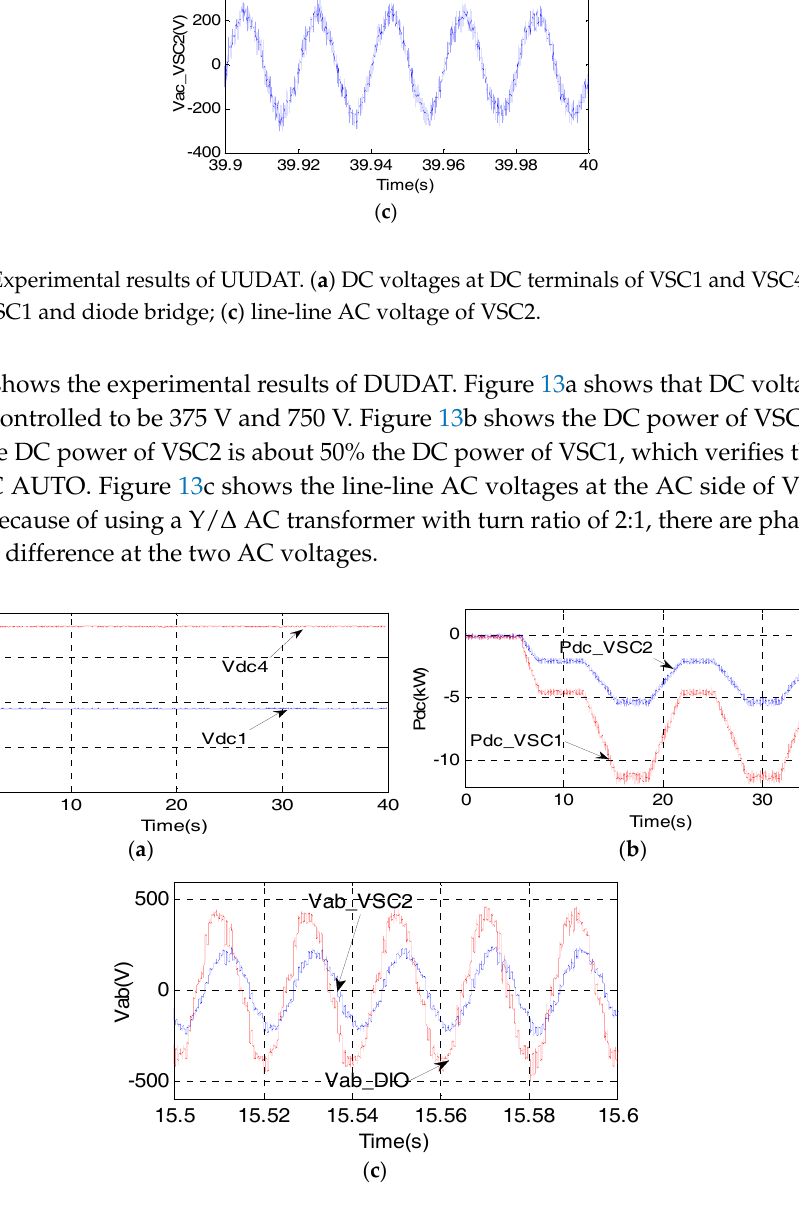
Figure 13. Experimental results of DUDAT. ( a ) DC voltages at DC terminal of VSC1 and VSC4; ( b ) DC power of VSC1 and diode bridge; ( c ) line-line AC voltage of VSC2 and diode bridge.